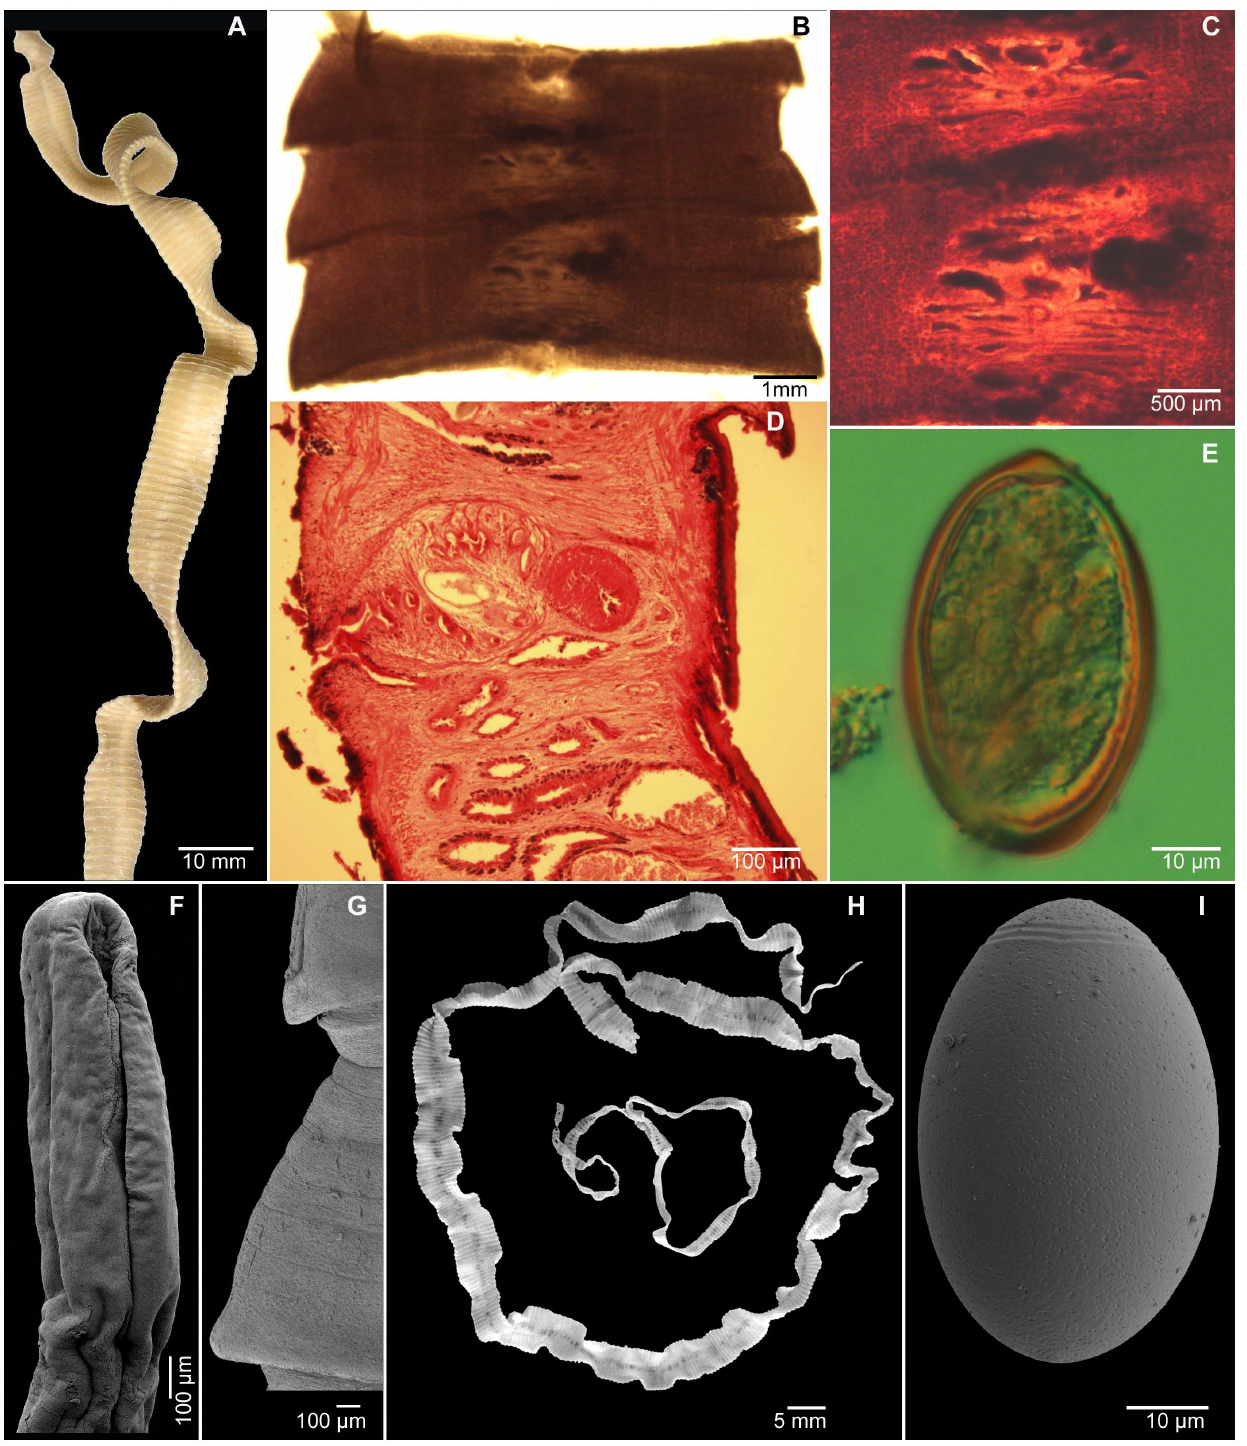
Figure 2. Morphology of Diphyllobothriumdendriticum . (A–E, G, H) Human case from the Czech Republic. (A) Whole worm. (B, C) Whole mount of gravid proglottids and their detail. (D) Sagittal section of gravid proglottids. (E, I) Egg in light microscope and scanning electron micrograph (SEM). (F) Scolex (SEM). (G) Lateral extremities of gravid segments (SEM). (H) Whole worm. (F, H) SEM of the specimen from experimentally infected hamster.